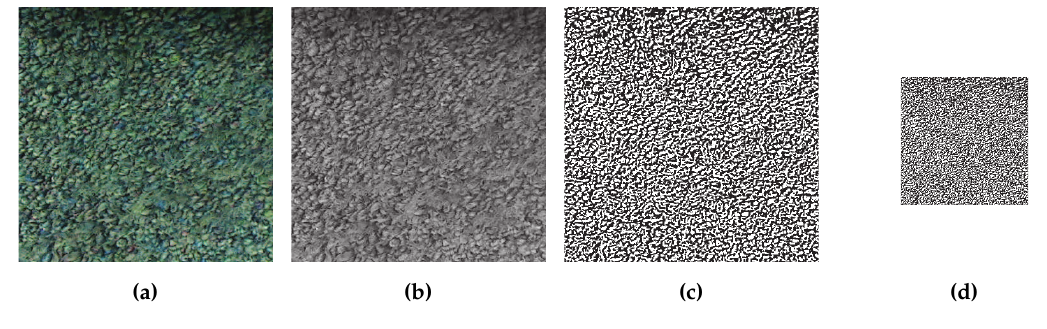
Figure 16. Each preprocessing step in the visual odometry algorithm: ( a ) original image; ( b ) converted to black and white; ( c ) filtered image; and ( d ) resampled image.